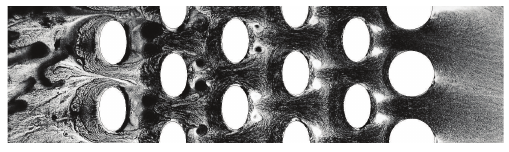
Figure 5: Surface flow visualization of G 2.2.